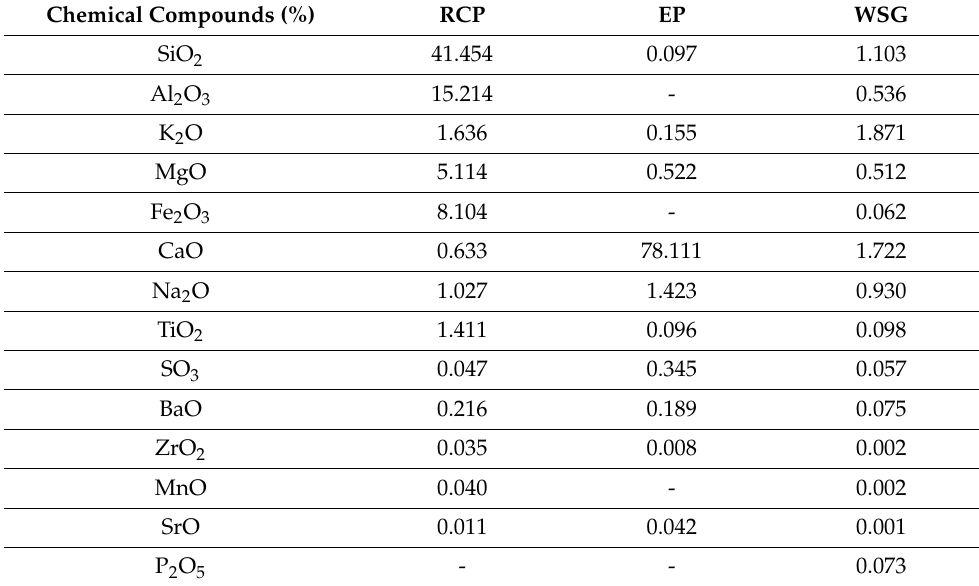
Table 2. Raw materials’ chemical